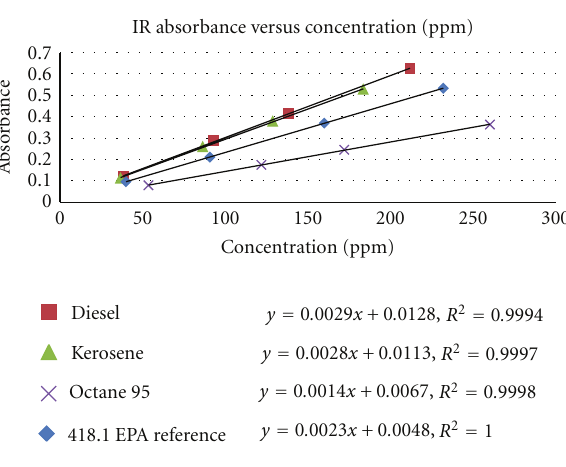
Figure 1: IR absorbance versus concentration